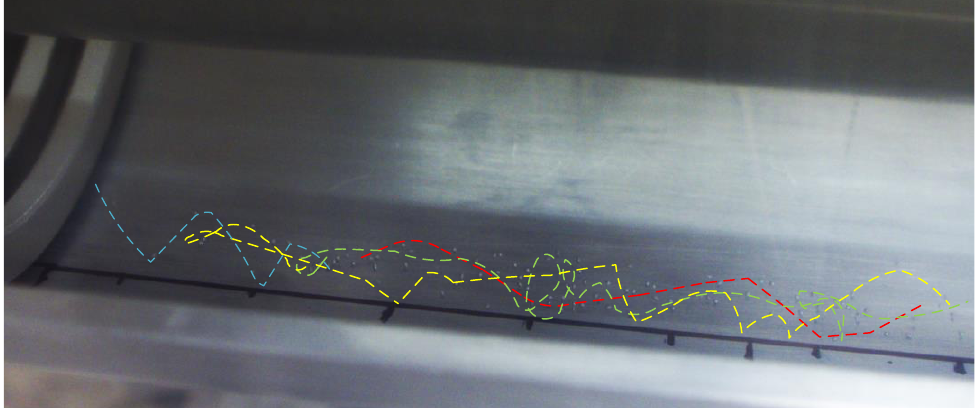
Figure 10. Particle trajectories in tests.